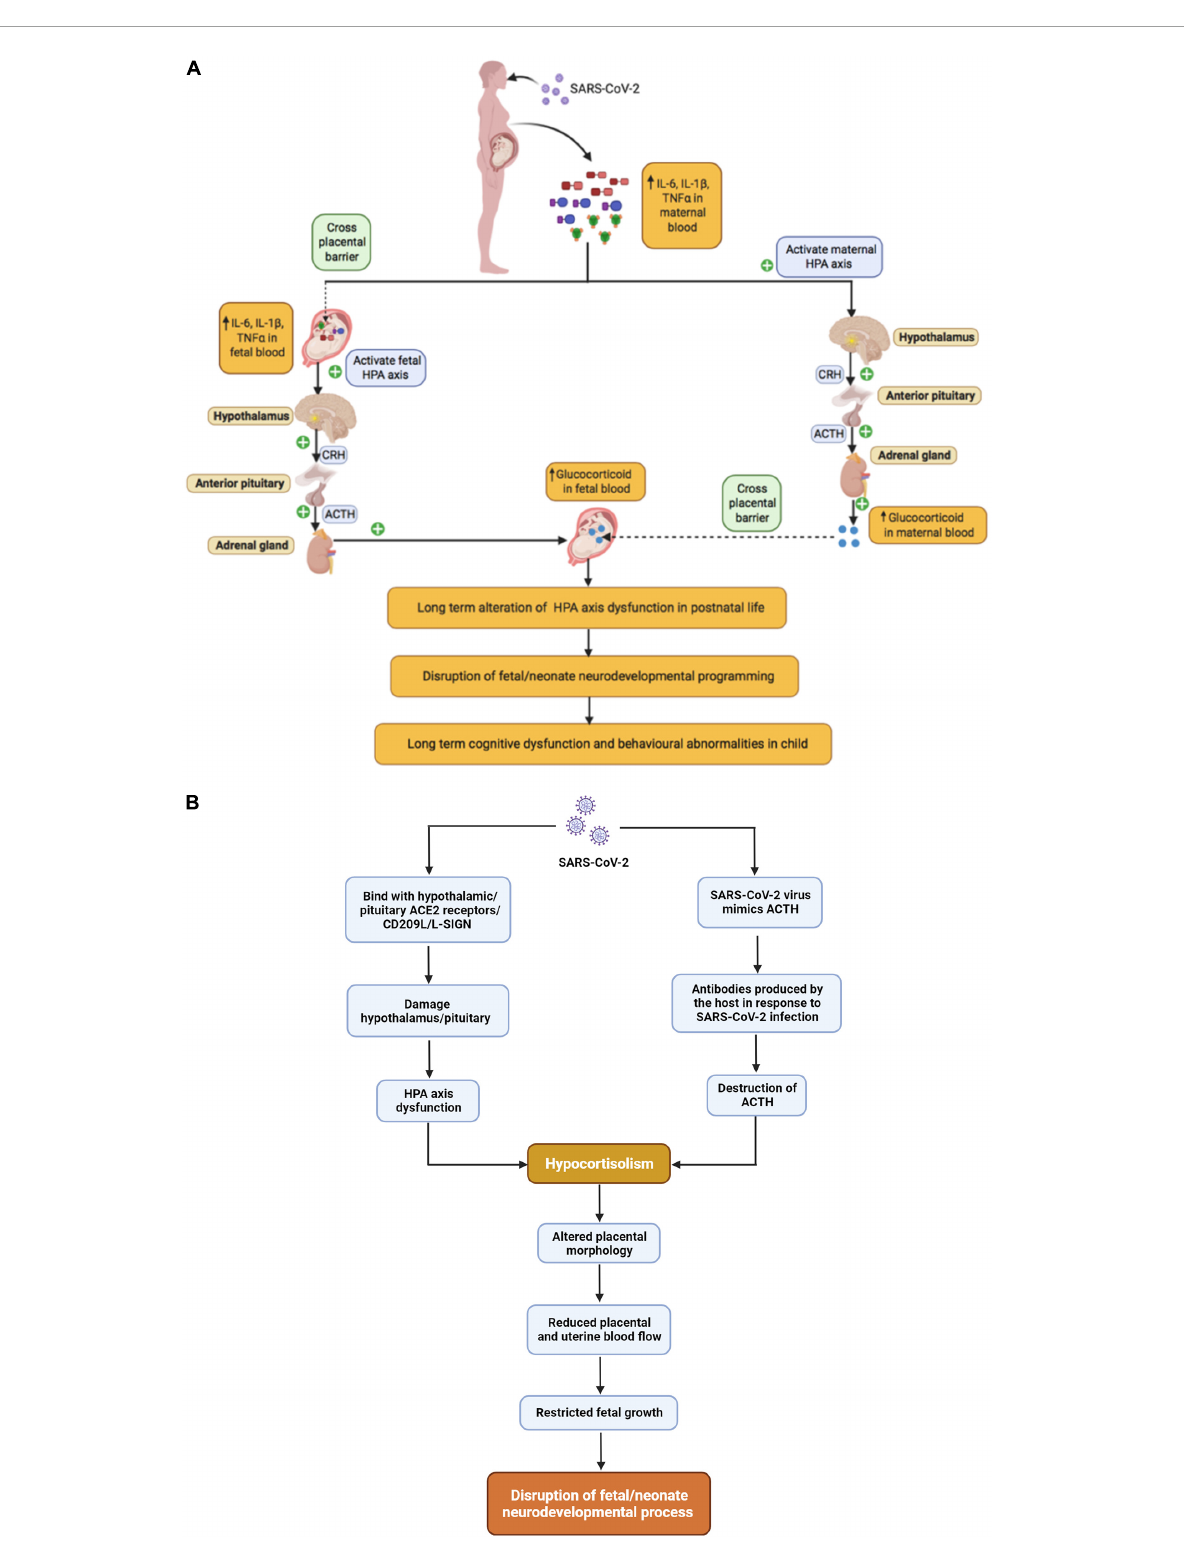
Frontiers in Neuroscience